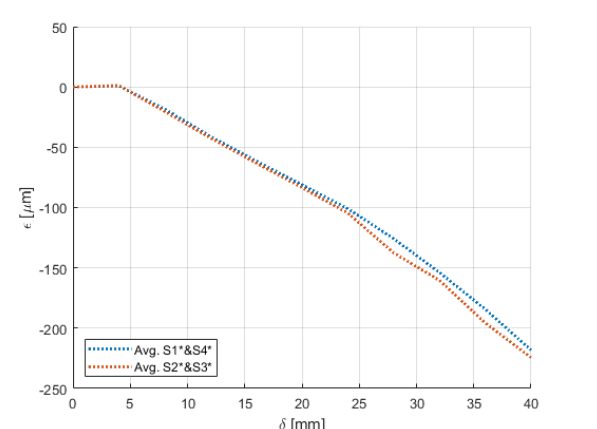
Figure 12. Strain trend in the bottom section of the wing undergoing bend-down with respect to deflection due to morphing.